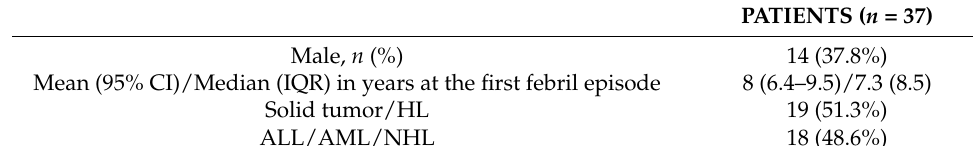
Table 1. Demographic and clinical characteristics of patients and